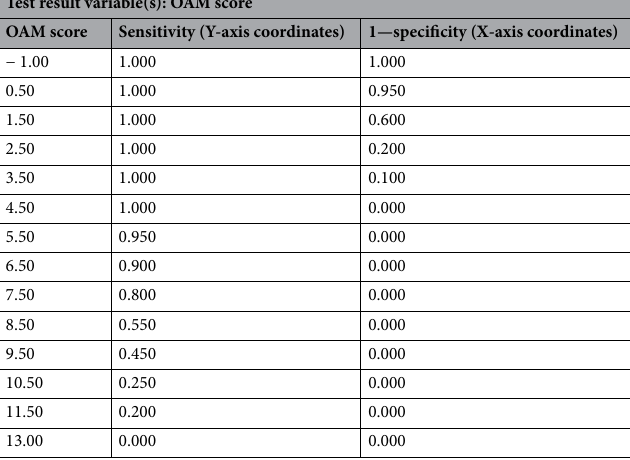
Table 5. Sensitivity and 1-specificity values at different AMS, calculated on the basis of the ROC curve (Coordinates of the curve) in B-B kinship analysis by X-STR. The smallest OAM cutoff score value is the minimum observed test value minus 1, and the most considerable cutoff value is the maximum perceived test value plus 1. All the other cutoff values are the averages of two consecutive ordered observed test